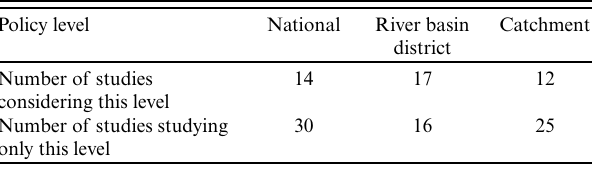
Table 2 . Number of studies per policy